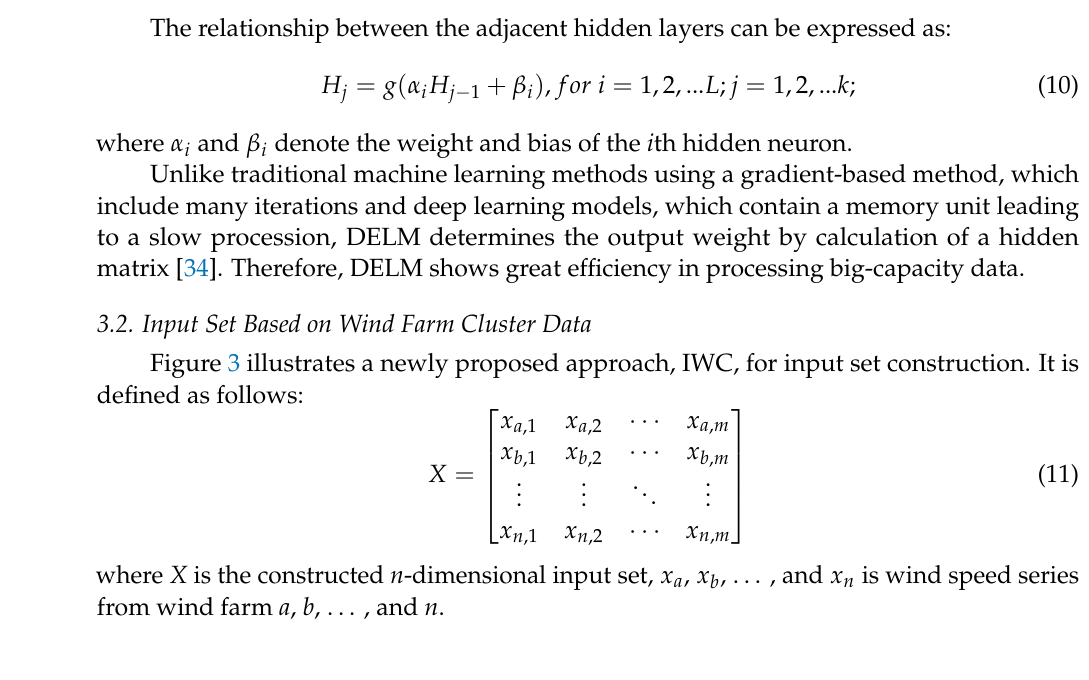
Figure 2. DELM configuration with n inputs and L -length hidden layer.